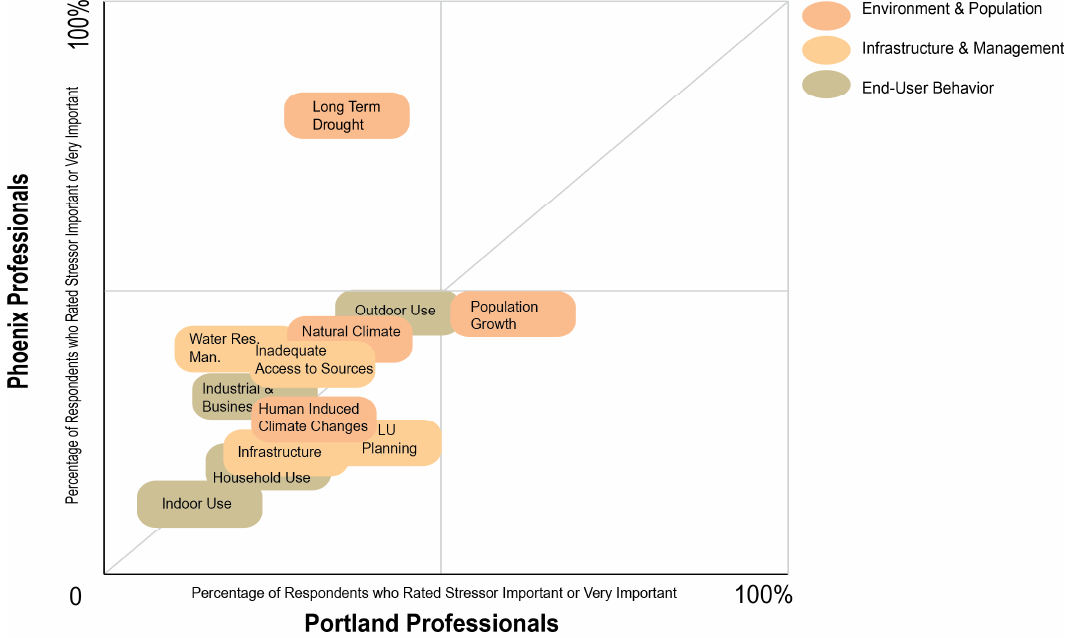
Figure 2. Water Resource Stressors rated at least 7/10 on a scale of importance, by region.